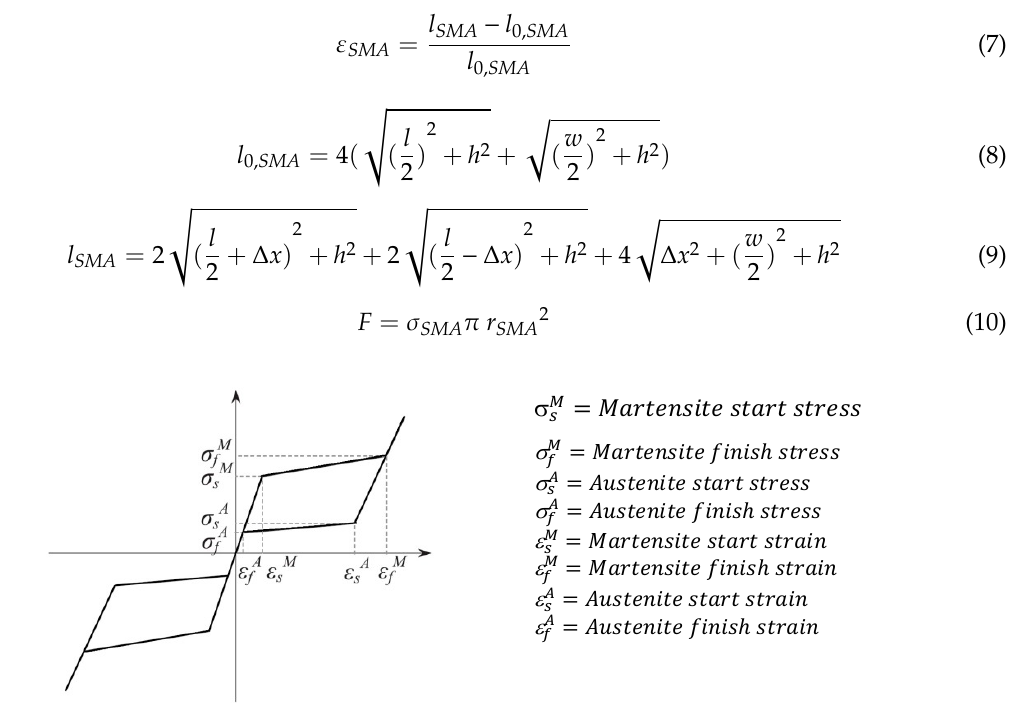
Figure 7. Idealized stress-strain diagram of SMA [54].